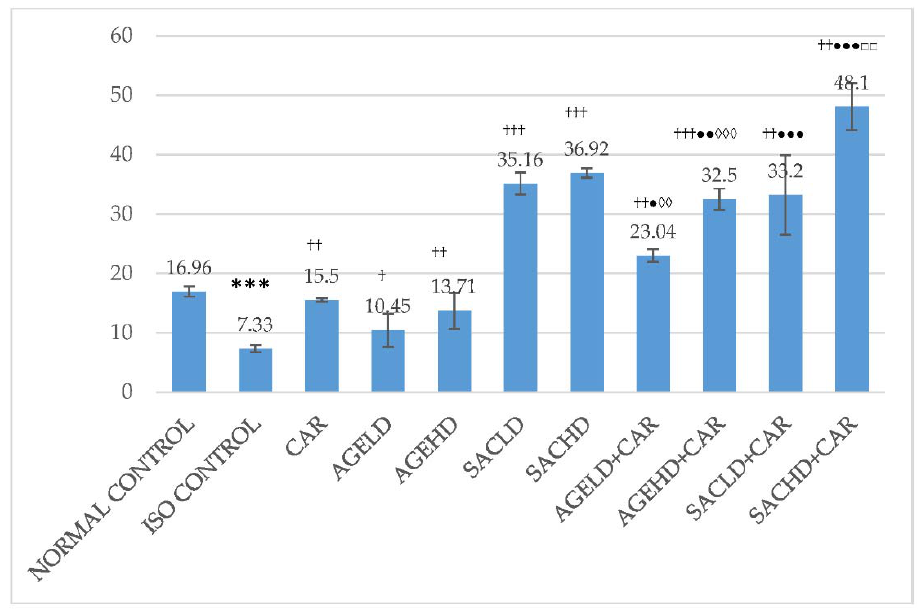
Figure 7. Effect on catalase activities. The data are given as mean ± SEM; *** p < 0.001 compared with normal control; † p < 0.05, †† p < 0.01, ††† p < 0.001 in comparison with ISO control; • p < 0.05, •• p < 0.01, ••• p < 0.001 in comparison with carvedilol; ♦♦ p < 0.01, ♦♦♦ p < 0.001 when compared (cid:3)(cid:3) p with respective AGE dose; < 0.01 when compared with respective SAC